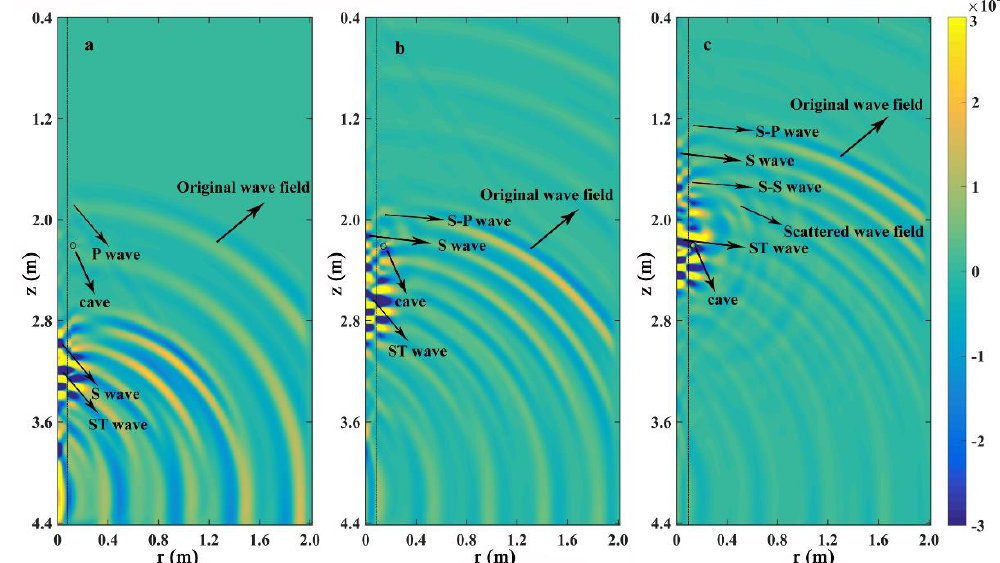
Figure 5. Wave-field snapshot of acoustic waves in a cave formation. ( a – c ) Wave fields at 0.9, 1.3 and 1.6 ms, respectively. Bar scale represents the amplitude of the wave .